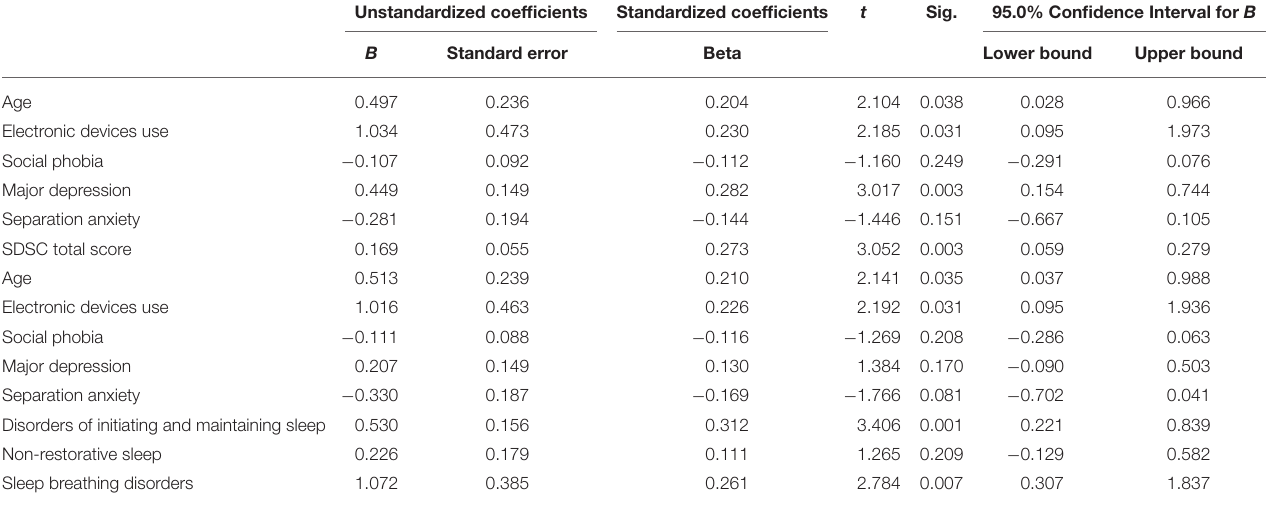
TABLE 5 | Multivariate analysis according to Enter Method: chronotype score taken as the dependent